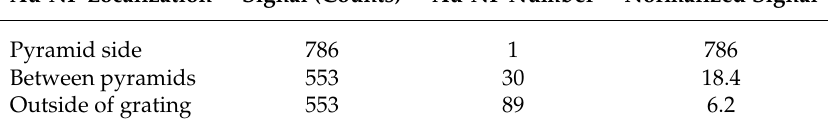
Table 1. Raman intensity for the Raman shift of 1338cm − 1 of the conjugate AuNP-DTNB on the metasurface vs. flat plane (in a.u.). The signal is collected from red frames, shown in Figure 31; normalized signal is obtained by dividing by the number of Au nanoparticles in a